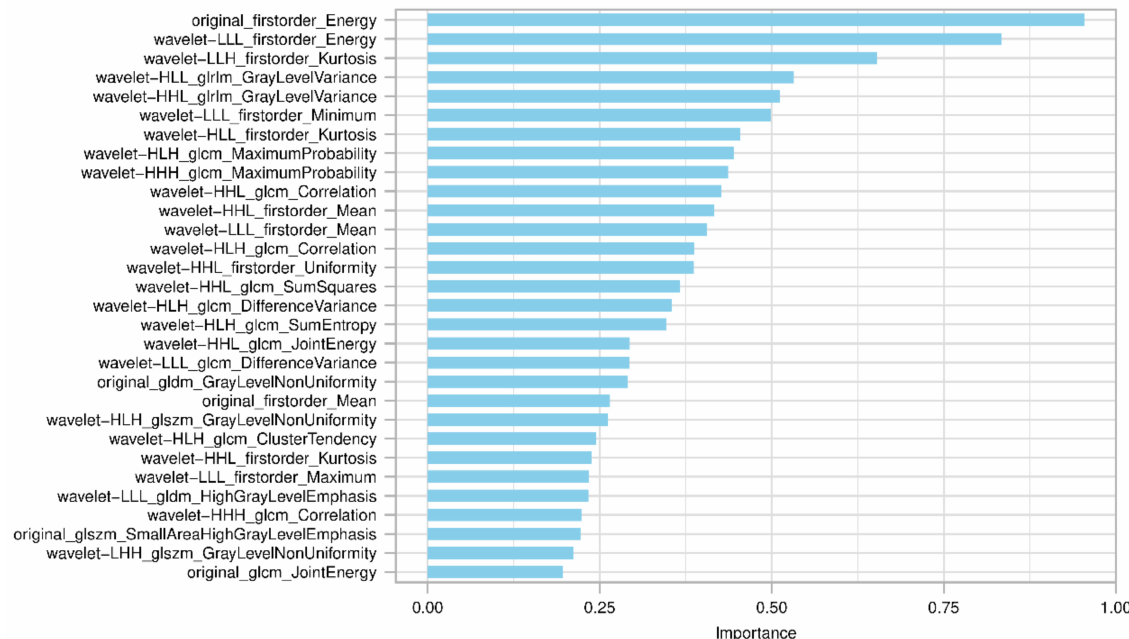
Figure 3. Top 30 radiomics features with importance evaluated by the Gini index in the random forest algorithm based on the development cohort. Gini Index is an effective measure of the impurity in the values of a dataset. In general, the higher the Gini index, the more important the feature